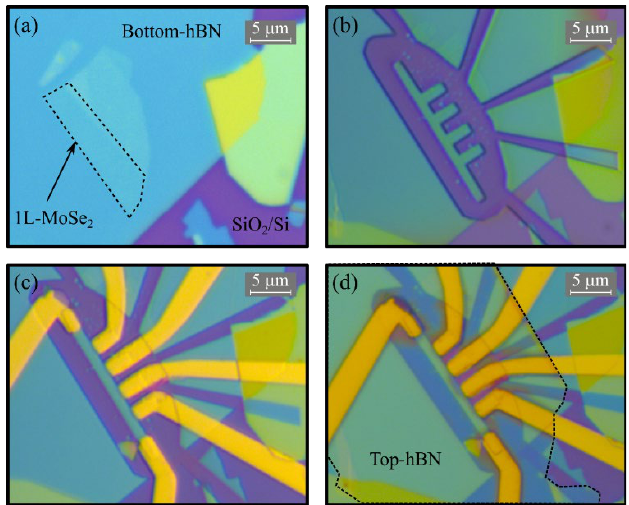
Figure 1. Optical microscope images of the 1L-MoSe 2 device at different stages of the fabrication process: ( a ) Transfer of the 1L-MoSe 2 above the bottom h-BN. ( b ) Definition of the device geometry after the dry etching. ( c ) Fabrication of the Ti/Au contacts. ( d ) Final device after the transfer of the top layer of h-BN.